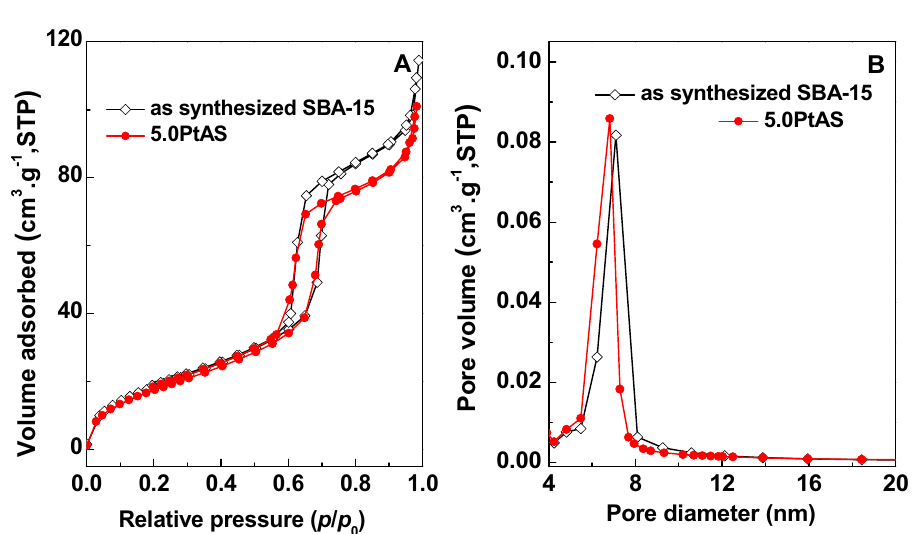
Figure 4. ( A ) N 2 adsorption–desorption isotherms and ( B ) pore size distributions of SBA-15, PtAS, and PtCS samples. Curves are plotted offset for clarity.